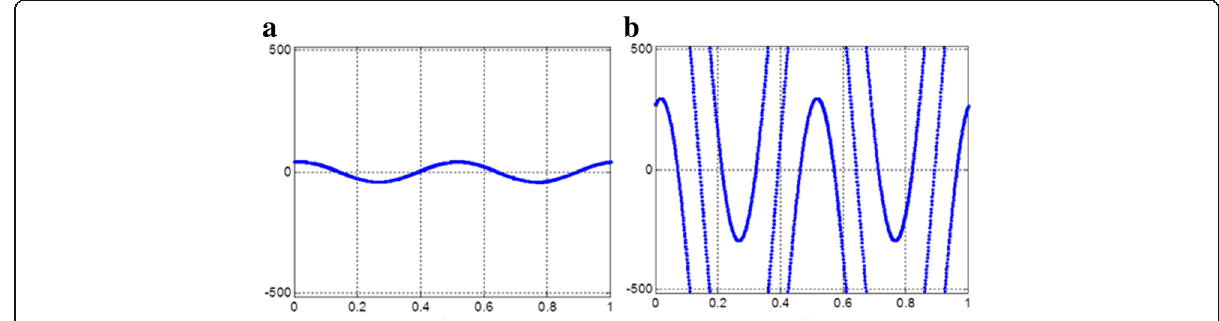
Fig. 5 Matching pixels of micro-Doppler curves. a The non-aliasing situation. b The aliasing situation